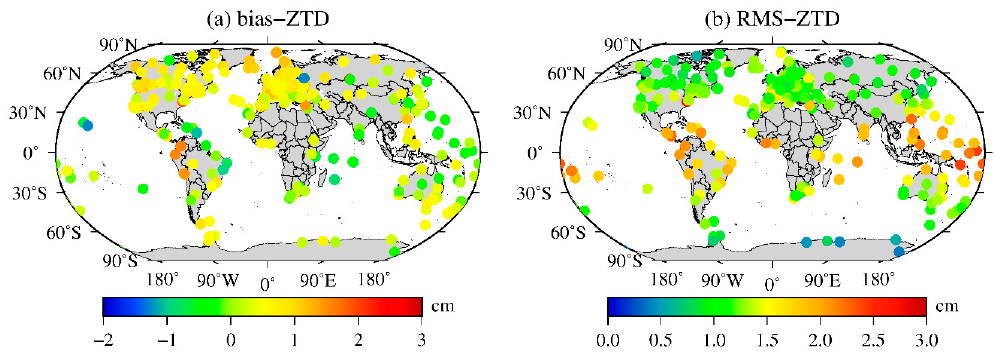
Figure 3. Global distributions of the annual means of the ( a ) bias and ( b ) RMS of the MERRA-2 ZTD values compared to the IGS ZTD values for 2016.